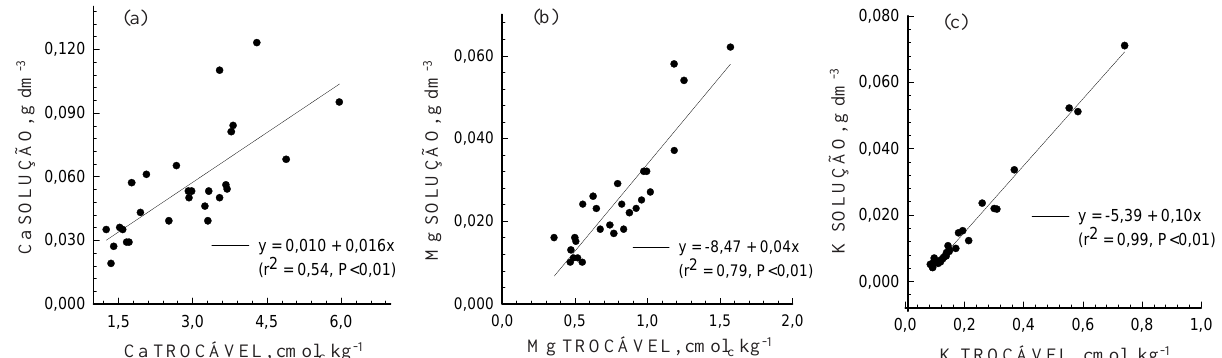
Figura 3. Relação entre os teores trocáveis e solúveis de Ca (a), Mg (b) e K (c) em um Latossolo Bruno alumínico em plantio direto, considerando três tratamentos de calagem (sem calcário, calcário incorporado e calcário